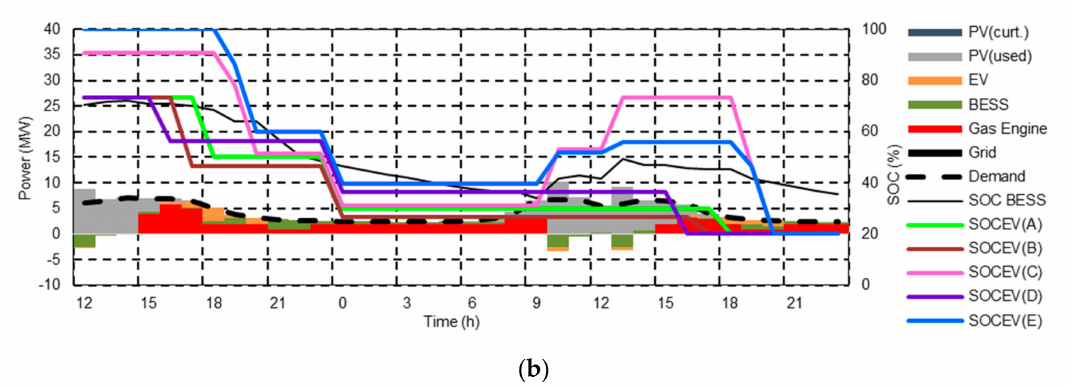
Figure 9. OED simulation results: ( a ) 30 May (Tuesday) and 31 May (Wednesday); ( b ) 25 May (Thursday) and 26 May